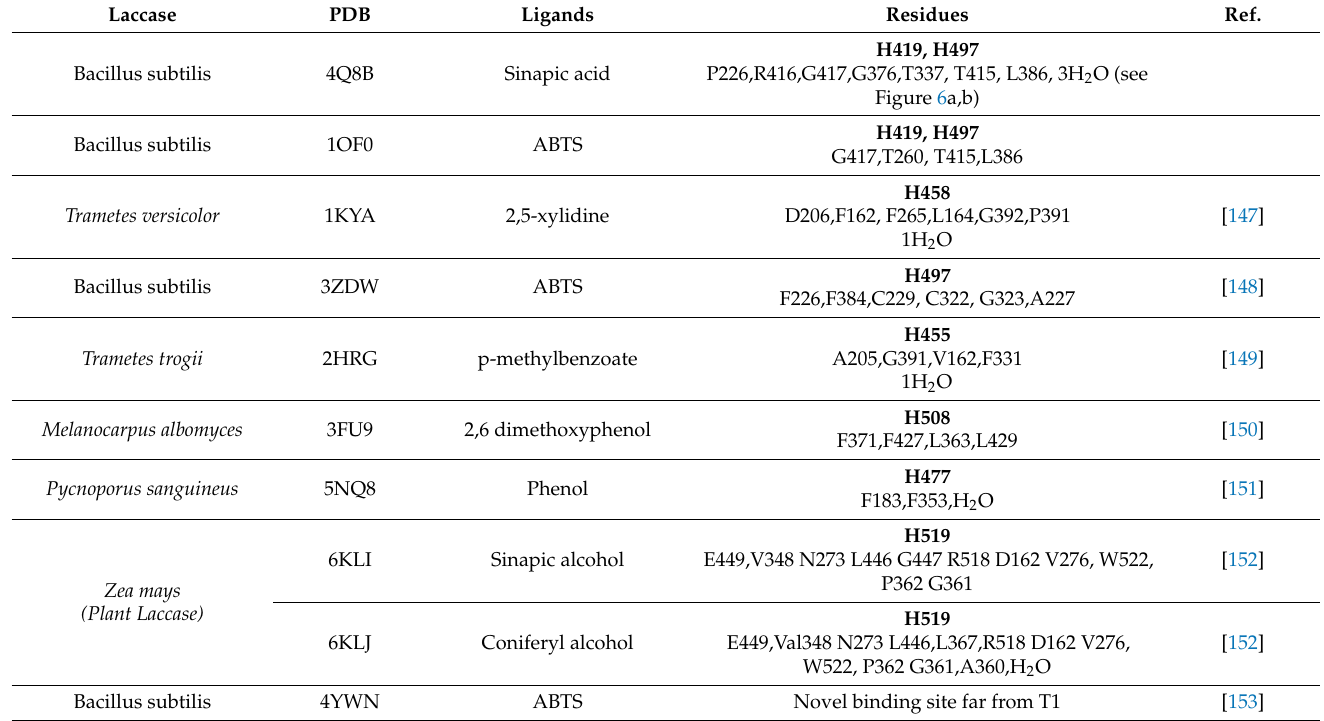
Table 2. Residues involved in the laccase–substrate binding in the PDB crystallographic structures with a ligand. In bold are the His residues, which are bound to the T1 Cu